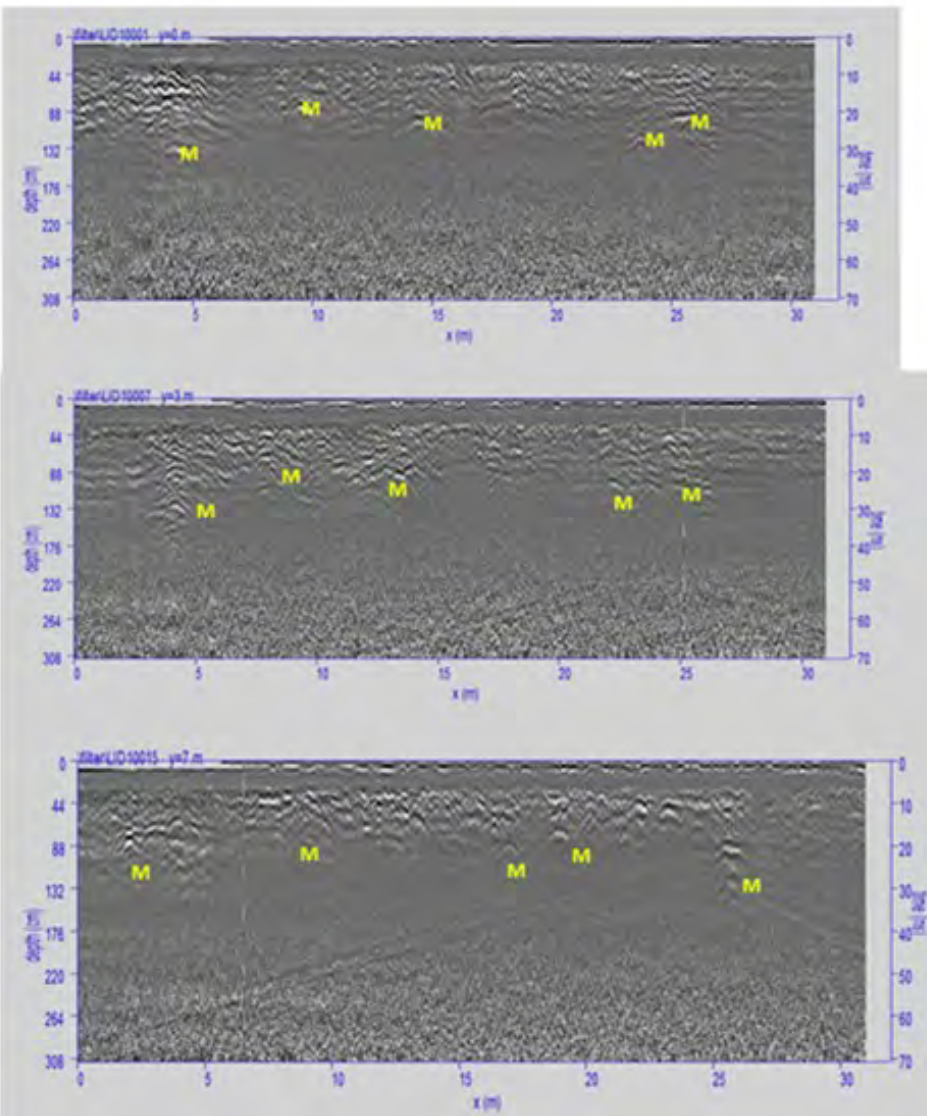
Figure 4. Processed radar sections relating to the profiles labeled 1, 7 and 15: M indicates reflection from